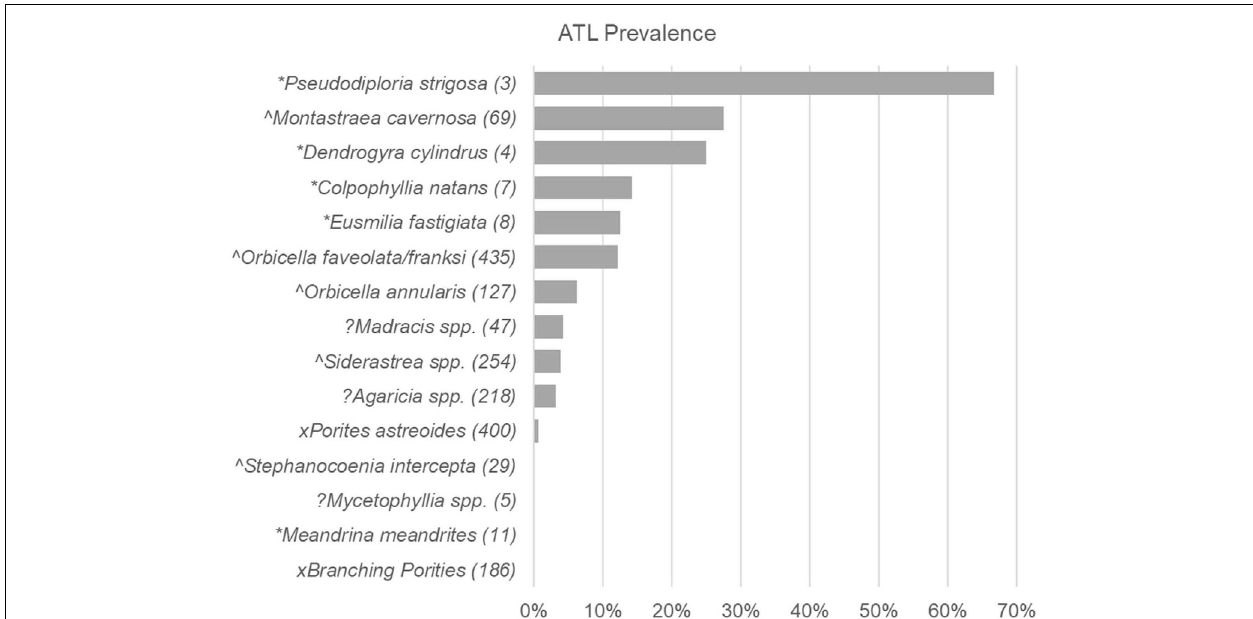
FIGURE 2 | Acute tissue loss disease prevalence among coral species at first recording of SCTLD. Prevalence (% of corals) with Acute Tissue Loss (ATL) disease among different species of corals recorded in pooled Territorial Coral Reef Monitoring Program (TCRMP) surveys completed when disease was first reported at a site (sample time points of first report of SCTLD for sites indicated in Table 1 ). Species susceptibility as listed in the case description (SCTLD Case Definition, 2018) are indicated by symbols as follows: *, highly susceptible; ∧ , intermediately susceptible; x, low or not susceptible; ?, Insufficient data to categorize. Numbers in parentheses indicate number of corals sampled